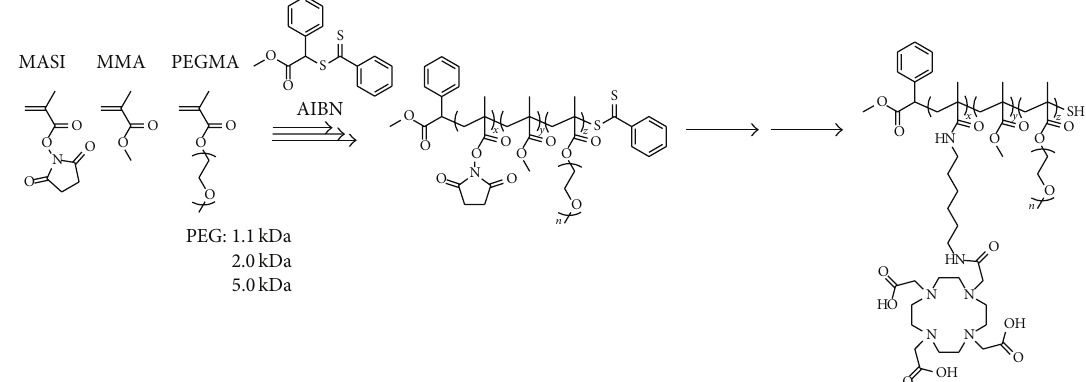
Figure 2: Scheme for poly(methyl methacrylate -co -methacryloxysuccinimide- graft -poly(ethylene glycol)).